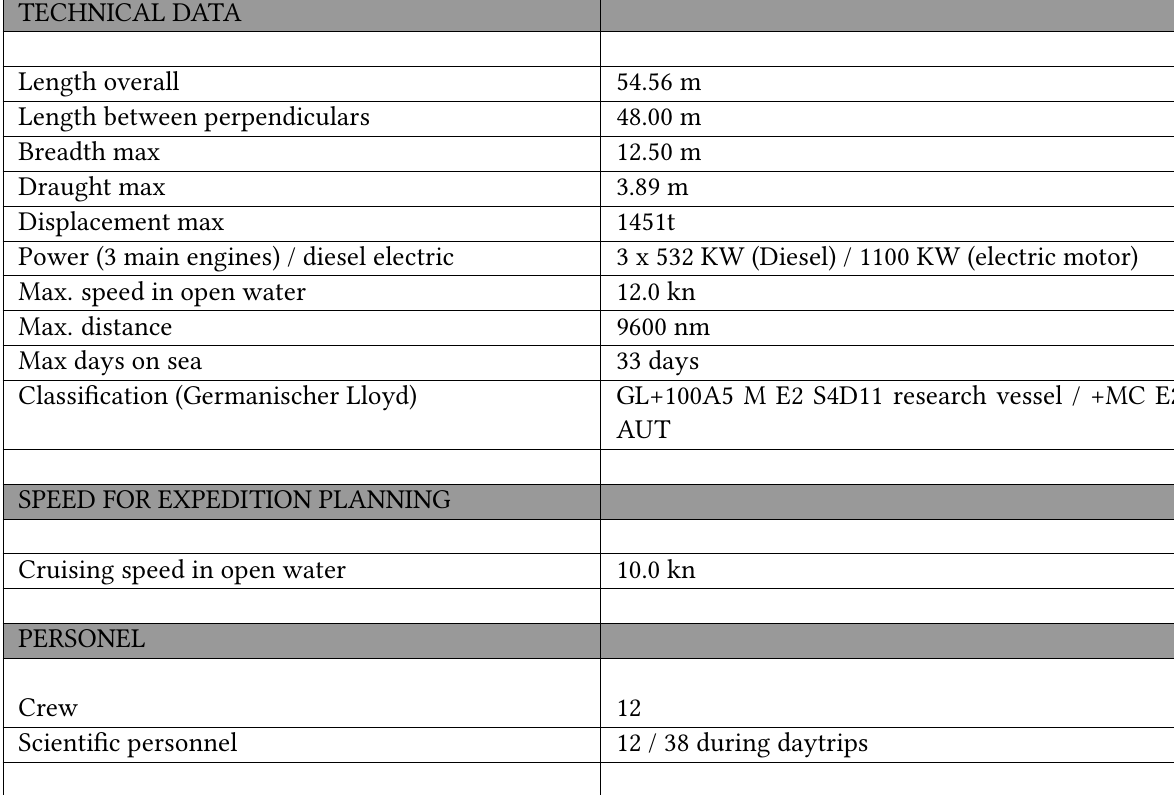
Table 1: Technical